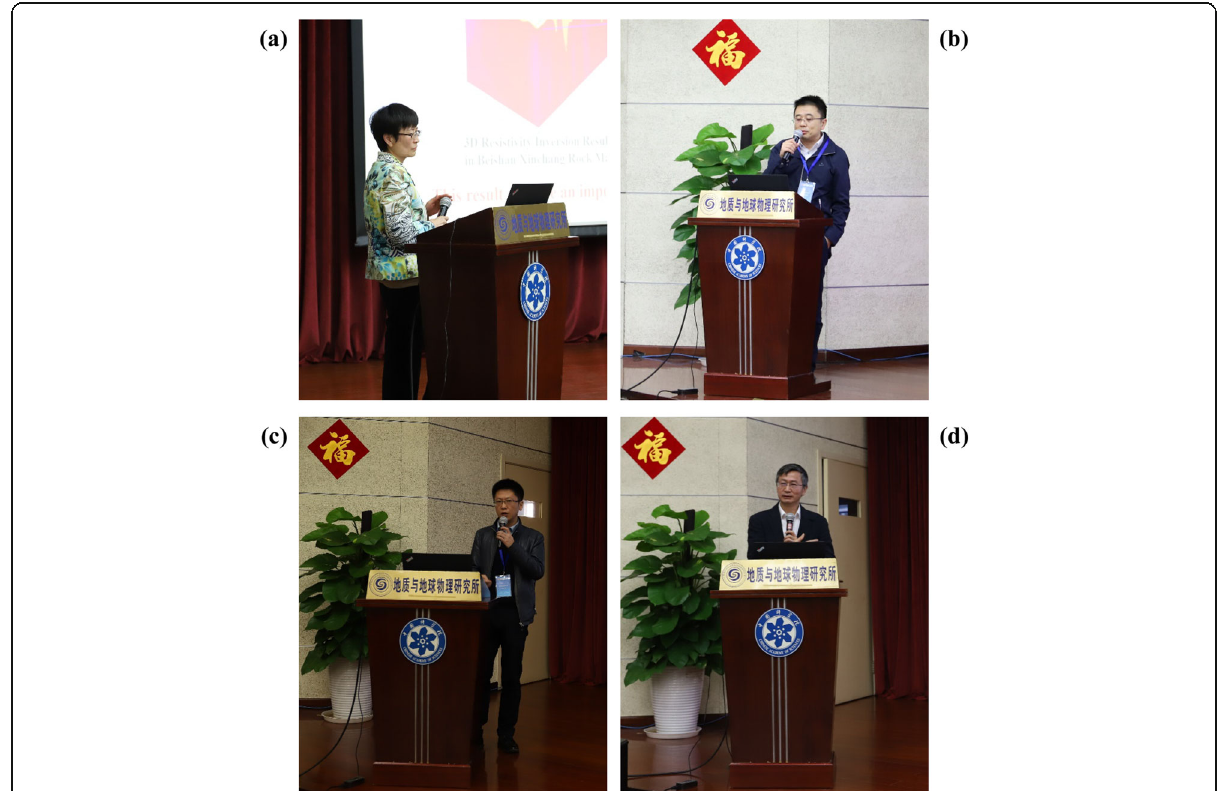
Fig. 6 Plenary lectures presented by Prof. Qingyun Di ( a ), Prof. Yu Huang ( b ), Prof. Lijun Su ( c ) and Prof. Xiwei Xu ( d )